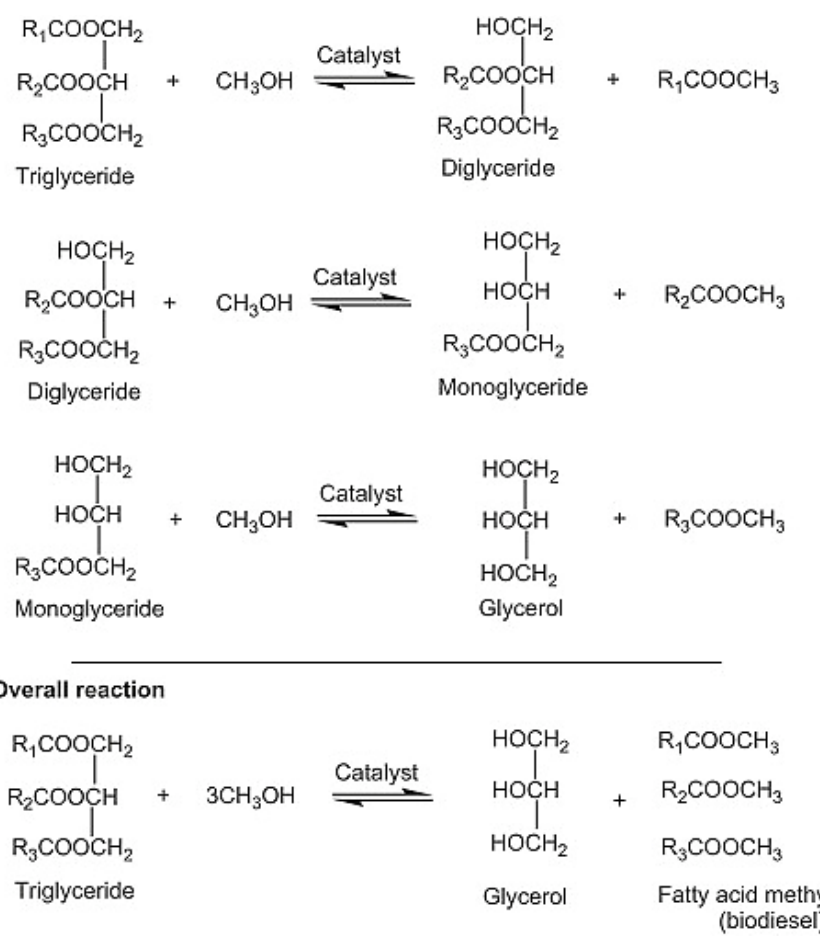
Figure 1. The overall transesterification reaction of triglyceride [8].